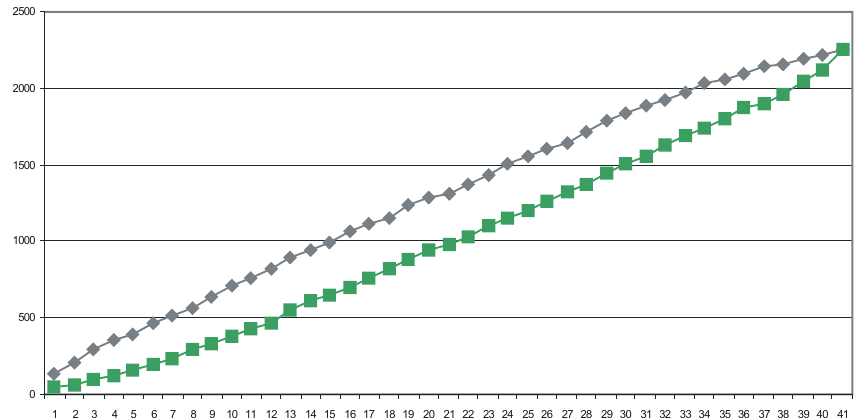
Figure 2. Cumulative values of the number of species in the herb layer of Krakow parks: grey diamonds in order of decreasing park area, green squares with an increasing area (see Fahrig 2017). X-axis: Order numbers of parks along with their increasing area; Y-axis: Cumulative number of